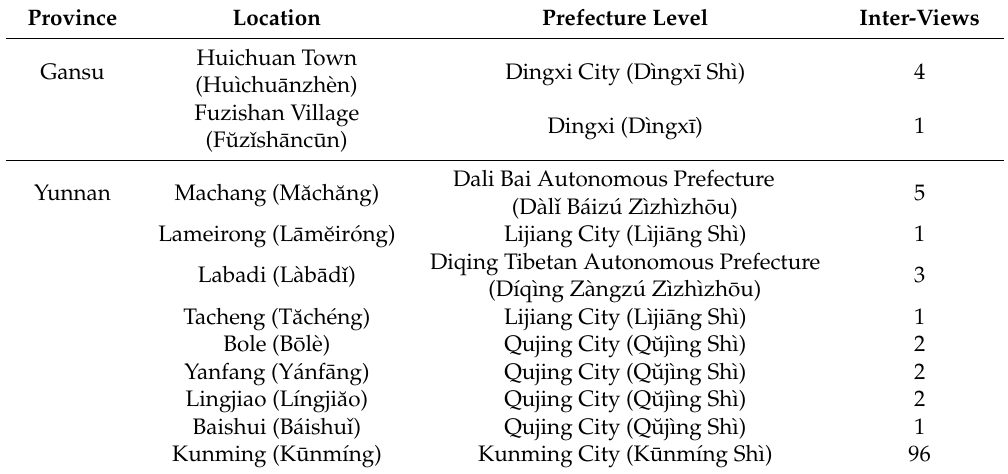
Table 2. Interviews in Gansu and Yunnan